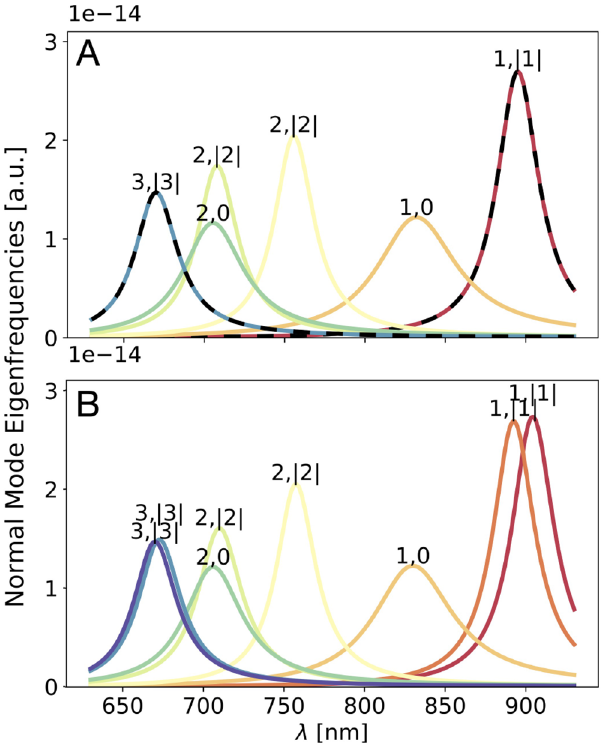
Fig. 5. RhoM QNM complex eigenfrequencies fi tted to Lor- entzians for the (A) Sq04 and (B) Sq22 facet orientations. Dashed lines represent degenerate